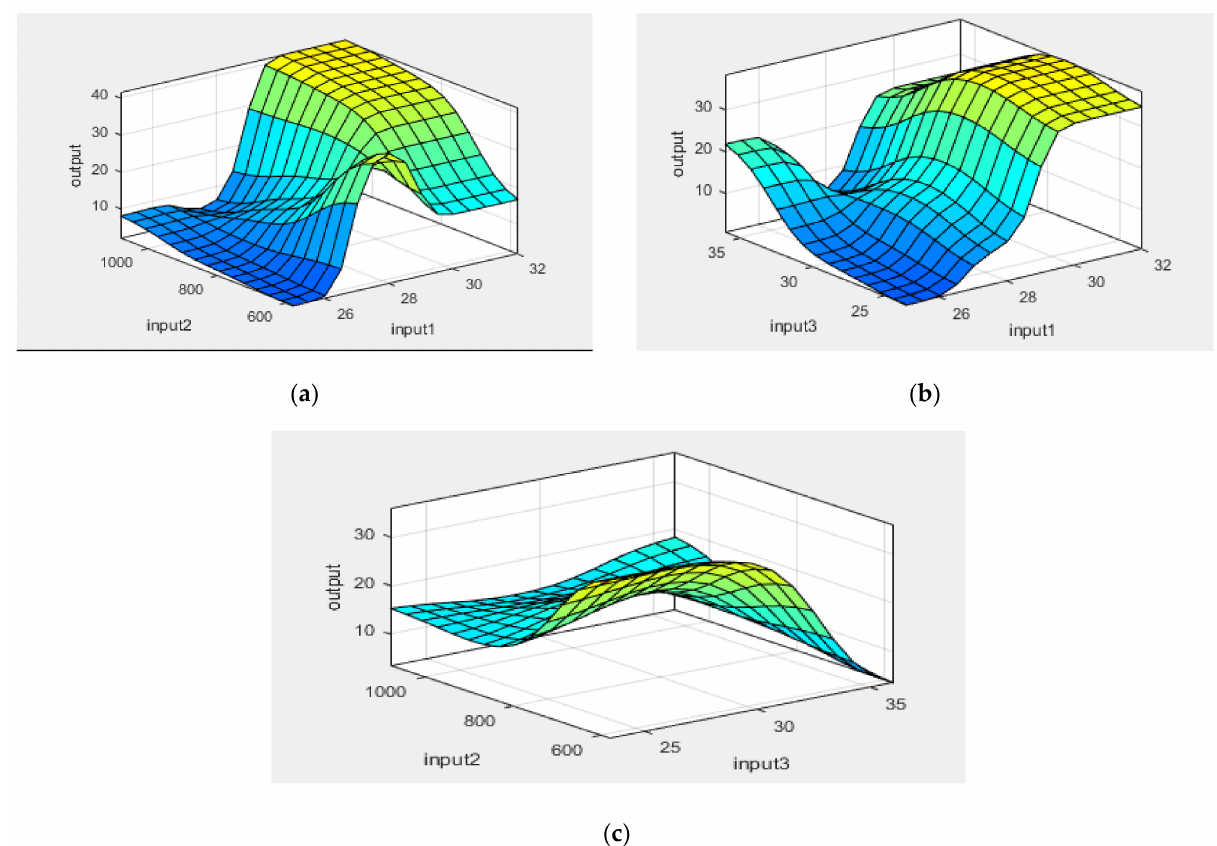
Figure 18. Surface viewer window between ( a ) (Ta, Ec) and fs; ( b ) i(Q, Ta) and fs; and ( c ) (Ec, Q) and fs.